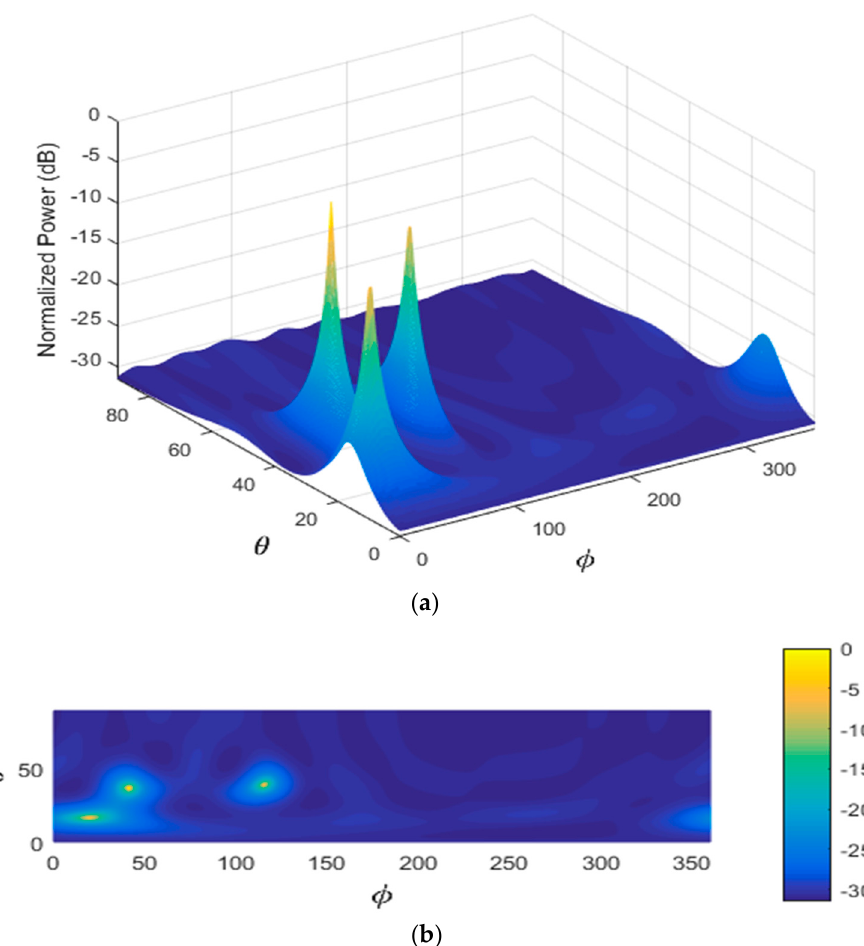
Figure 5. Performance estimation of the PDDA method with three AOAs. ( a ) 3D plot of the PDDA method; ( b ) 2D plot of the PDDA method.